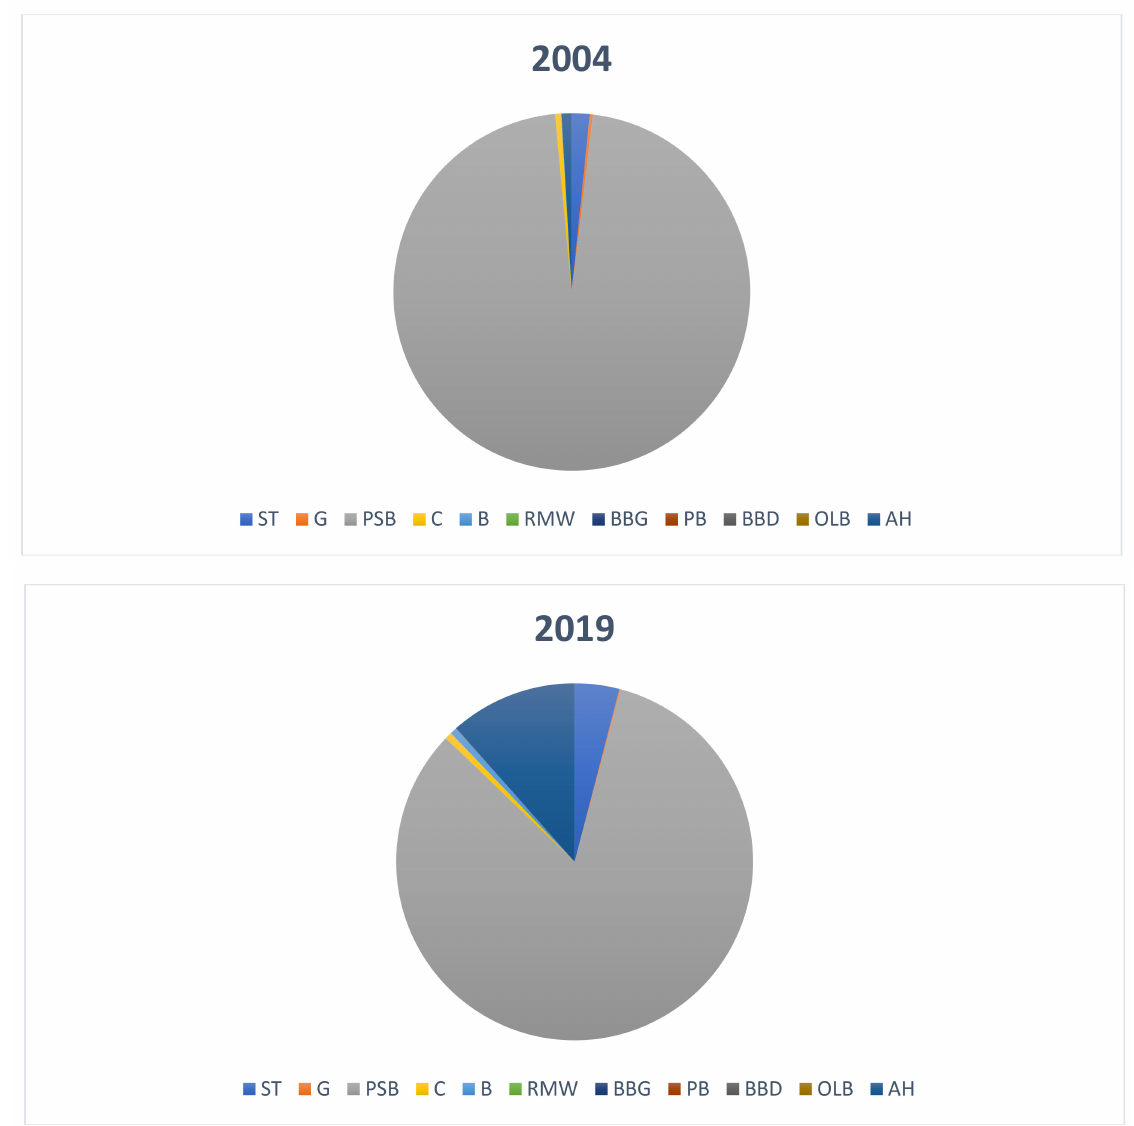
Figure 5. Structure of RES used by the household sector in 2004 and 2019, percentage. Comment: ST—Solar thermal